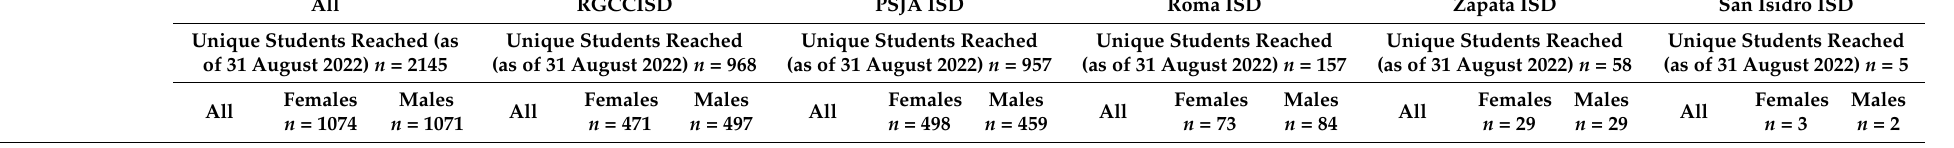
Table A1. Descriptive of the students by school district who received HPV vaccines directly through our school-based program ( n =